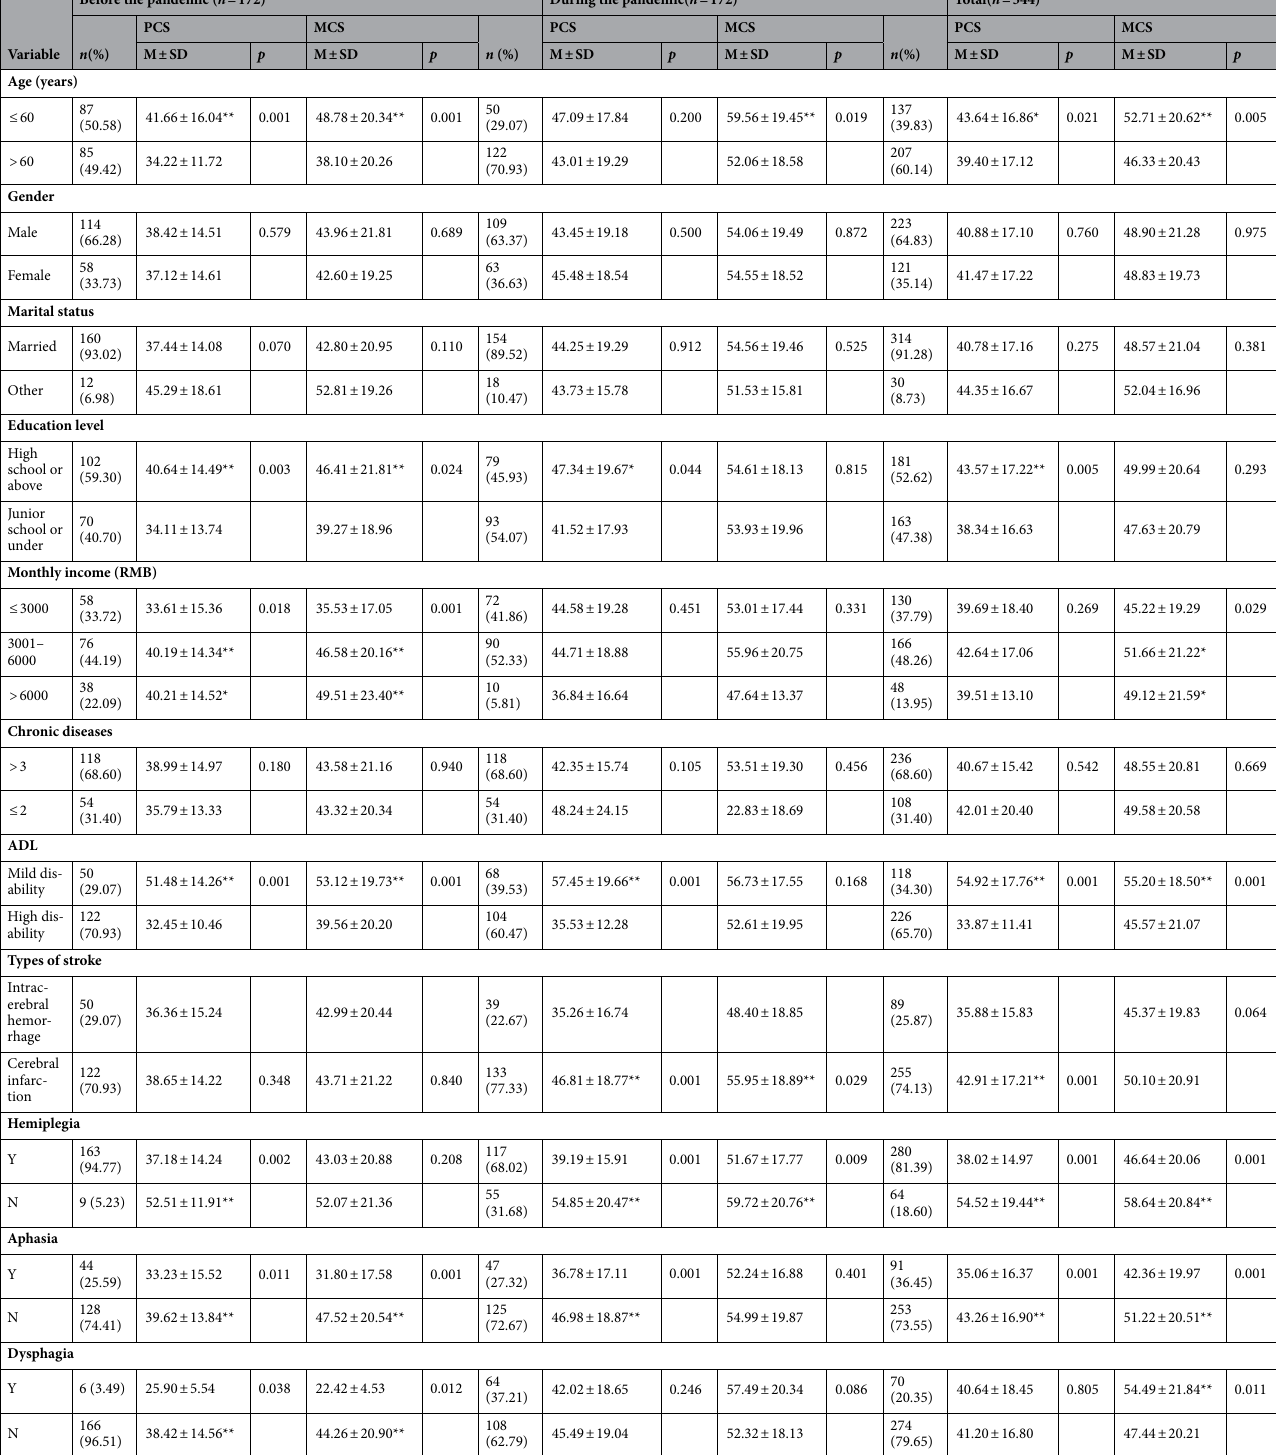
Table 1. Comparisons of PCS and MCS by demographic and clinical characteristics of patients with stroke ( n = 344). * p < 0.05, ** p <